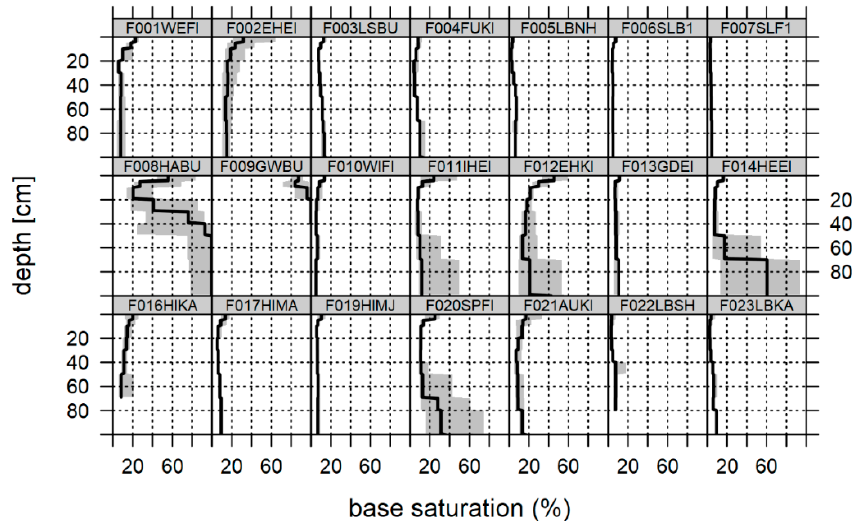
Figure 6. Depth profiles of pH(CaCl 2 ) in the mineral soil for the most recent soil inventory (cf. Figure 3) at the permanent soil monitoring plots in Lower Saxony. The solid line describes the median of six composite samples taken at 24 locations and the grey areas the error range (5th and 95th percentile).